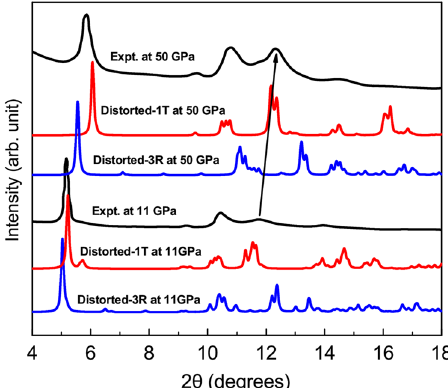
Fig. 2 The simulated XRD patterns for ReS 2 phases compared with experiments. Blue line represents the distorted-3R (the known ambient structure) and red line presents the distorted-1T (new structure predicted in this work) ReS 2 at 11 and 50 GPa compared with the experimental data ( black line ) from ref. 36, where we use the same X-ray wavelength ( λ = 0.4959 Å) as experiments. Our predicted